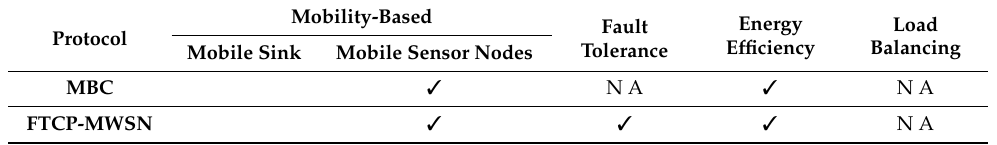
Table 7. Comparison of mobile-node-based routing protocols for